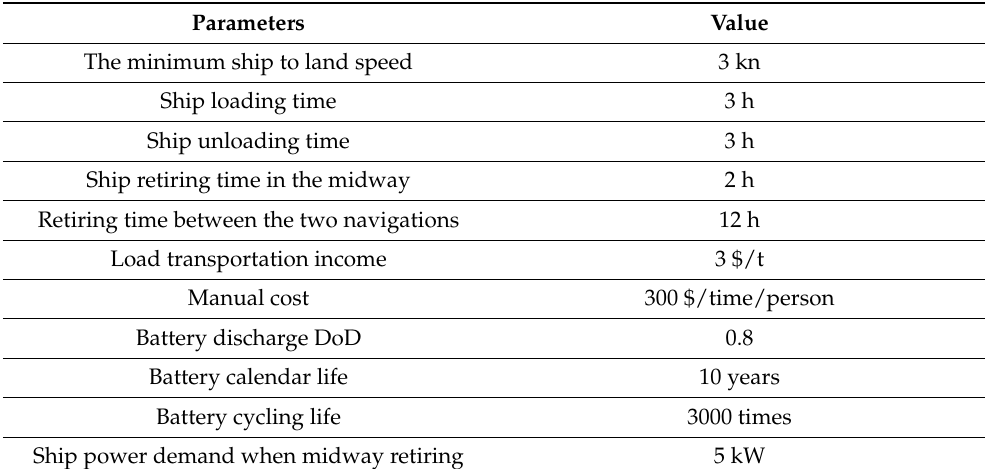
Table 2. Parameters of a battery-powered bulk freighter